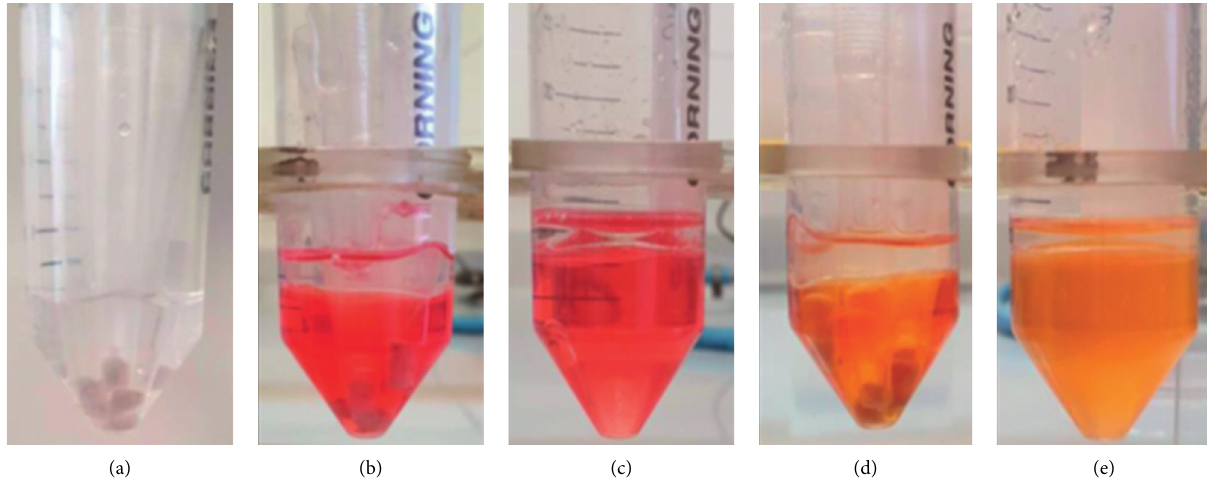
Figure 3: Representative picture of the model developed: (a) plastic cones with the mucoadhesive lipogel incorporated immersed in artificial saliva; (b) plastic cones with the mucoadhesive lipogel incorporated immersed in Lacto-Counter Assay (LCA) reagent after 2h of incubation with artificial saliva; (c) artificial saliva immerged in LCA reagent after 2 h of incubation with plastic cones containing the mucoadhesive lipogel incorporated; (d) color change of sample B solution in LCA; and (e) color change of sample C solution in